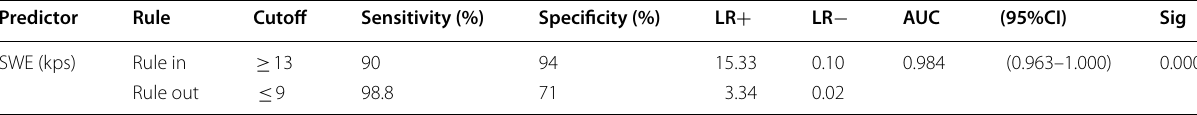
PVT Portal vein thrombosis, SWE Shear wave elastography, LR Likelihood ratio, AUC Area under the curve, CI Confidence